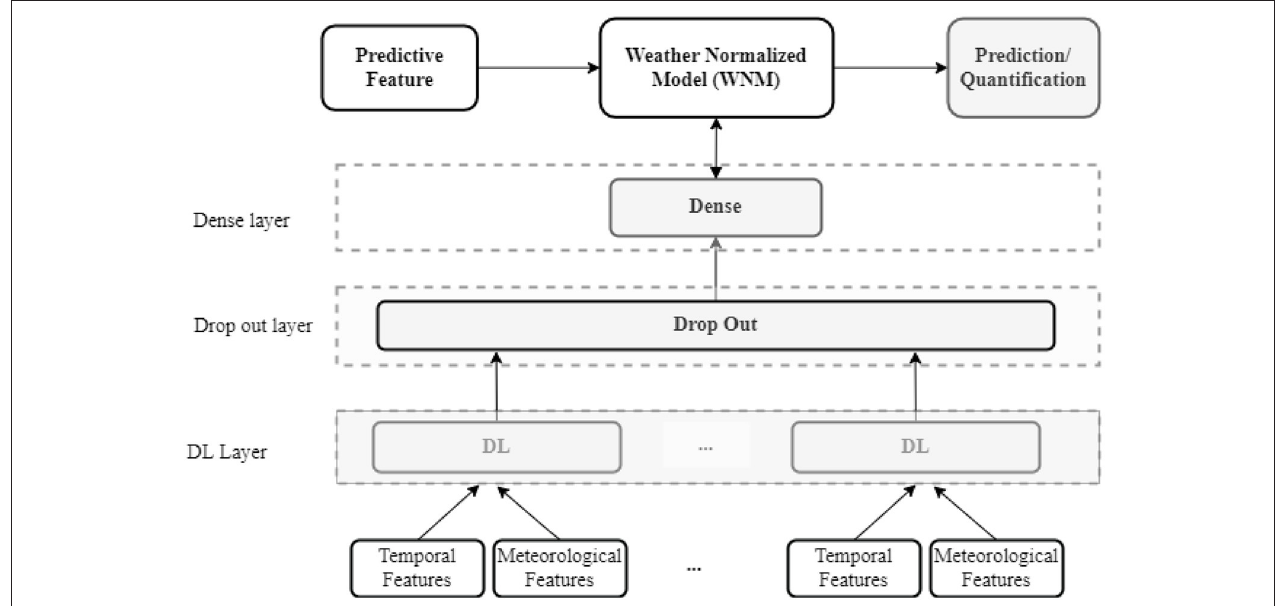
FIGURE 4 | The model with general DL